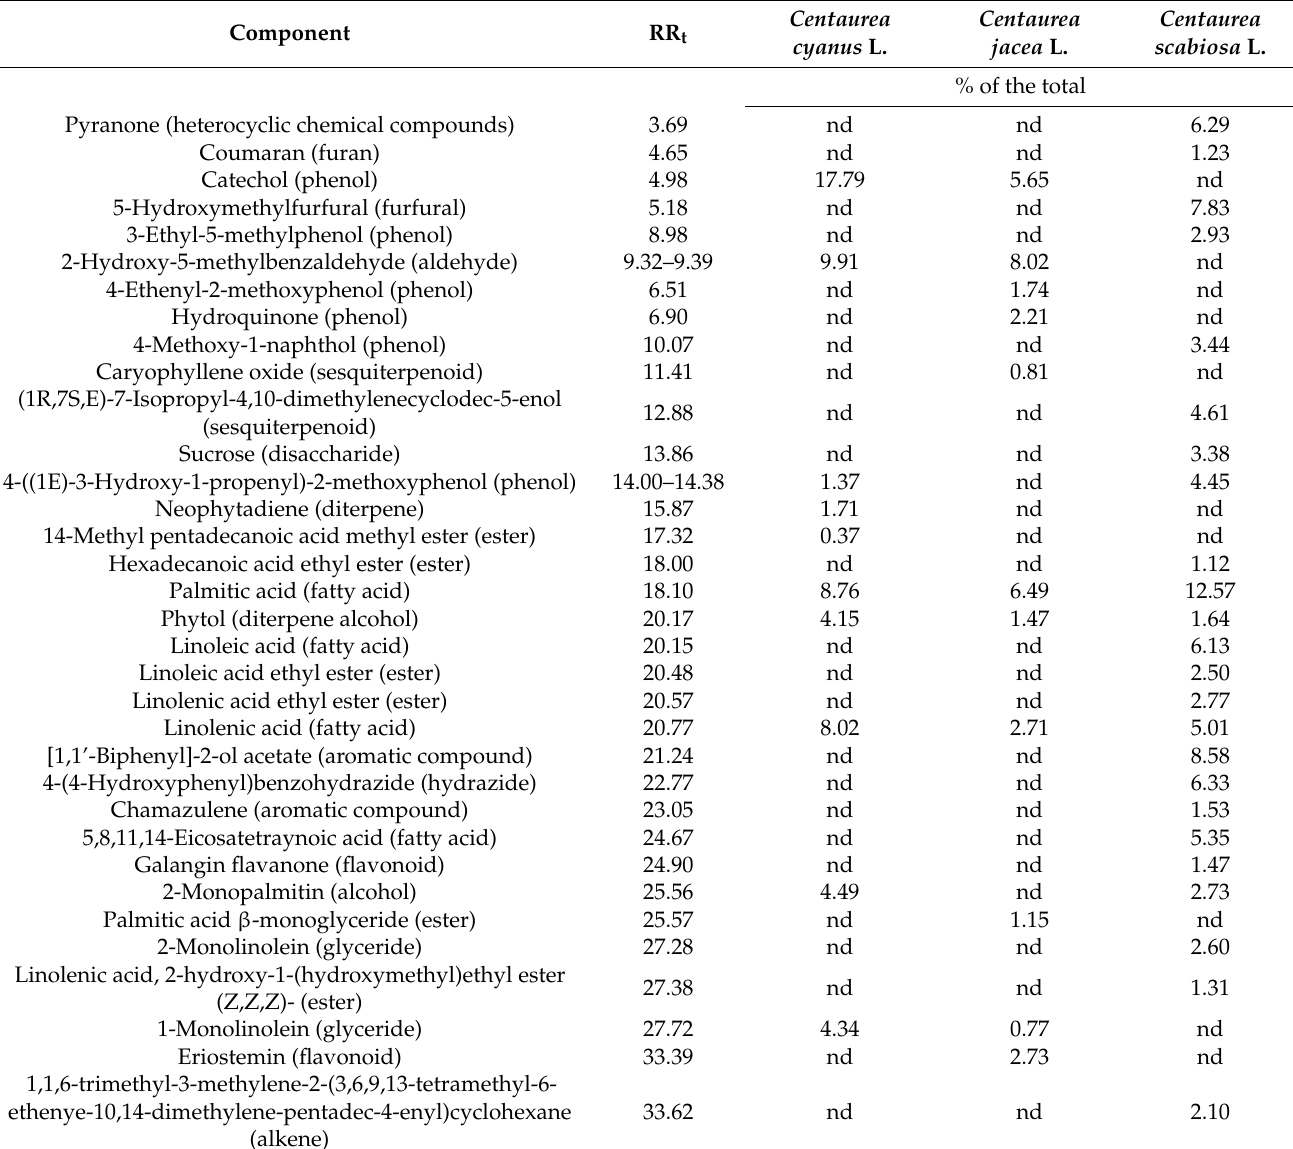
Table 1. Phytochemical composition of ethanol extracts produced from Centaurea cyanus L., Centaurea jacea L., and Centaurea scabiosa L. flowers. Component